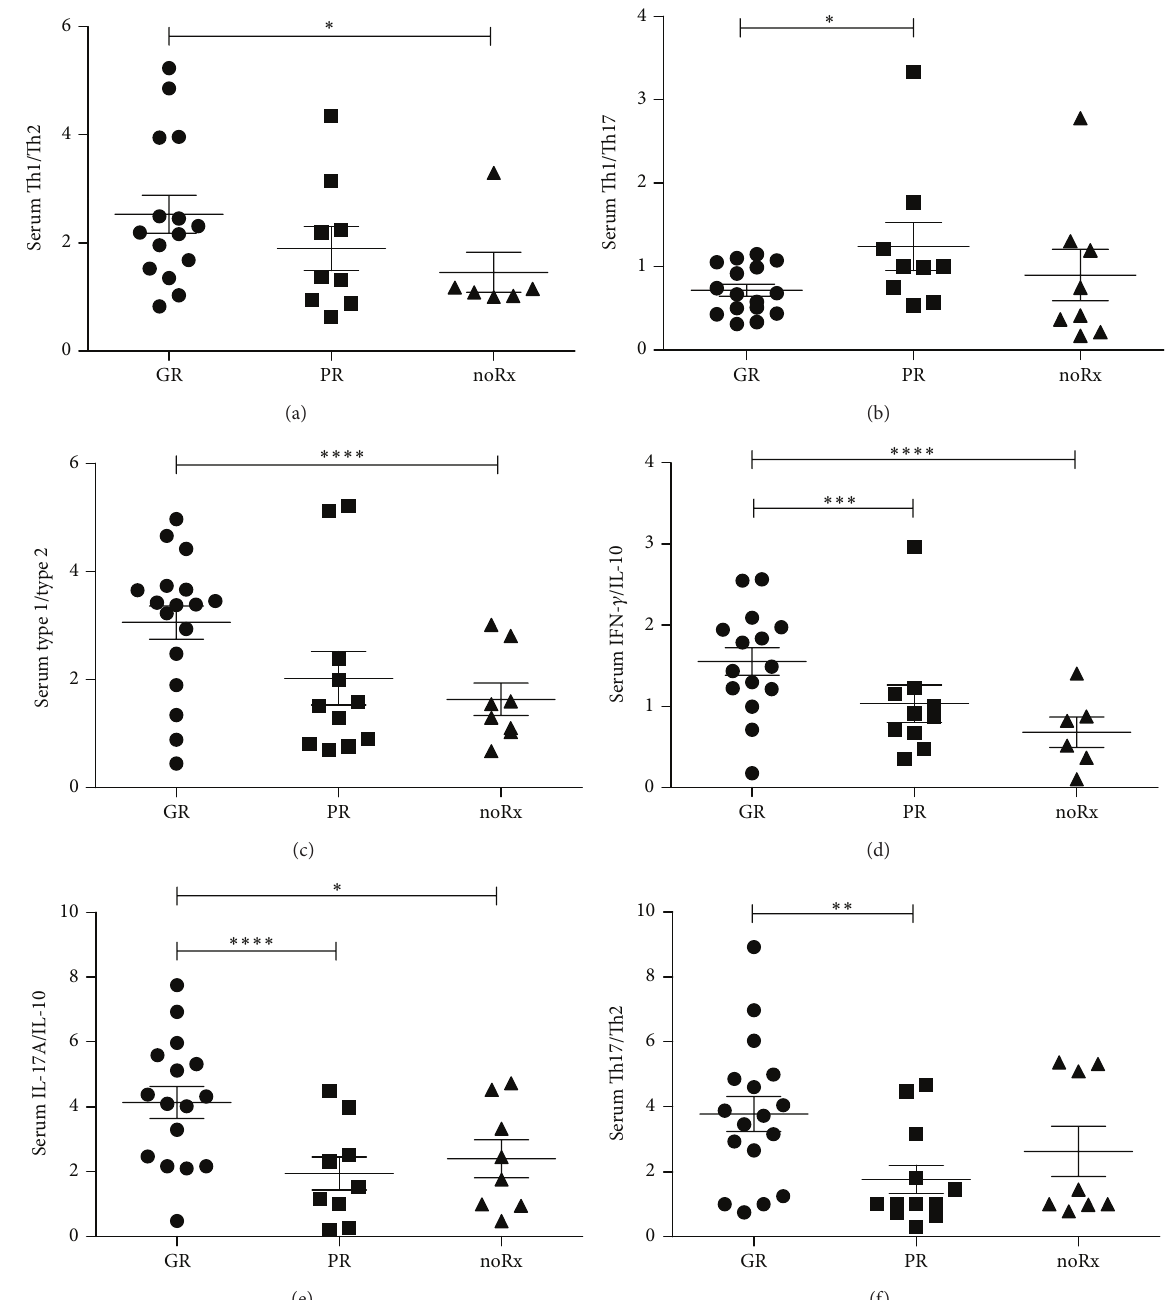
Figure 2: Serum cytokine ratios in GR, PR, and noRx patients. (a) Th1/Th2, (b) Th1/Th17, (c) Type 1/Type 2, (d) IFN- 𝛾 /IL-10, (e) IL-17A/IL-10, and (f) Th17/Th2. ∗ 𝑃 = 0.05 , ∗∗ 𝑃 = 0.03 , ∗∗∗ 𝑃 = 0.02 , ∗∗∗∗ 𝑃 = 0.01